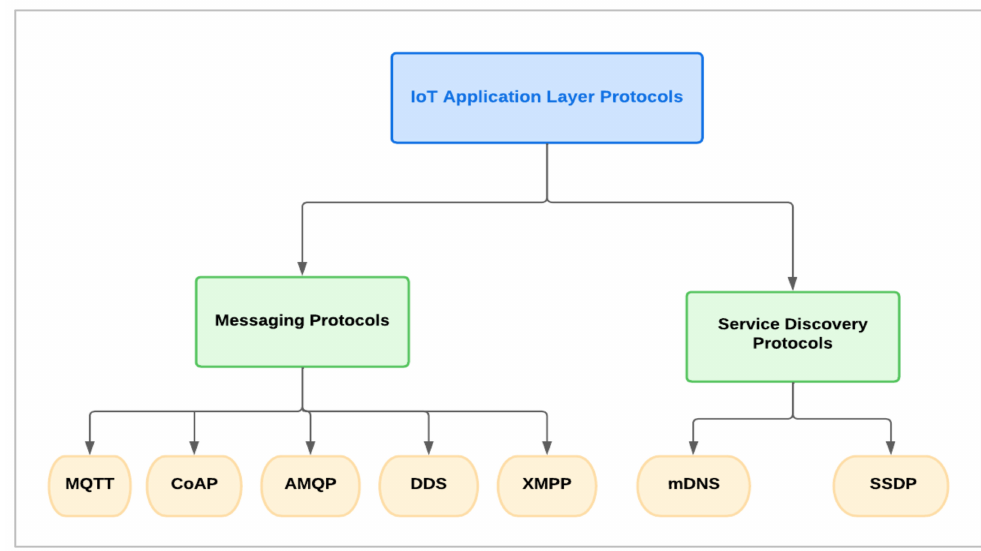
Figure 3. IoT application-layer protocols.